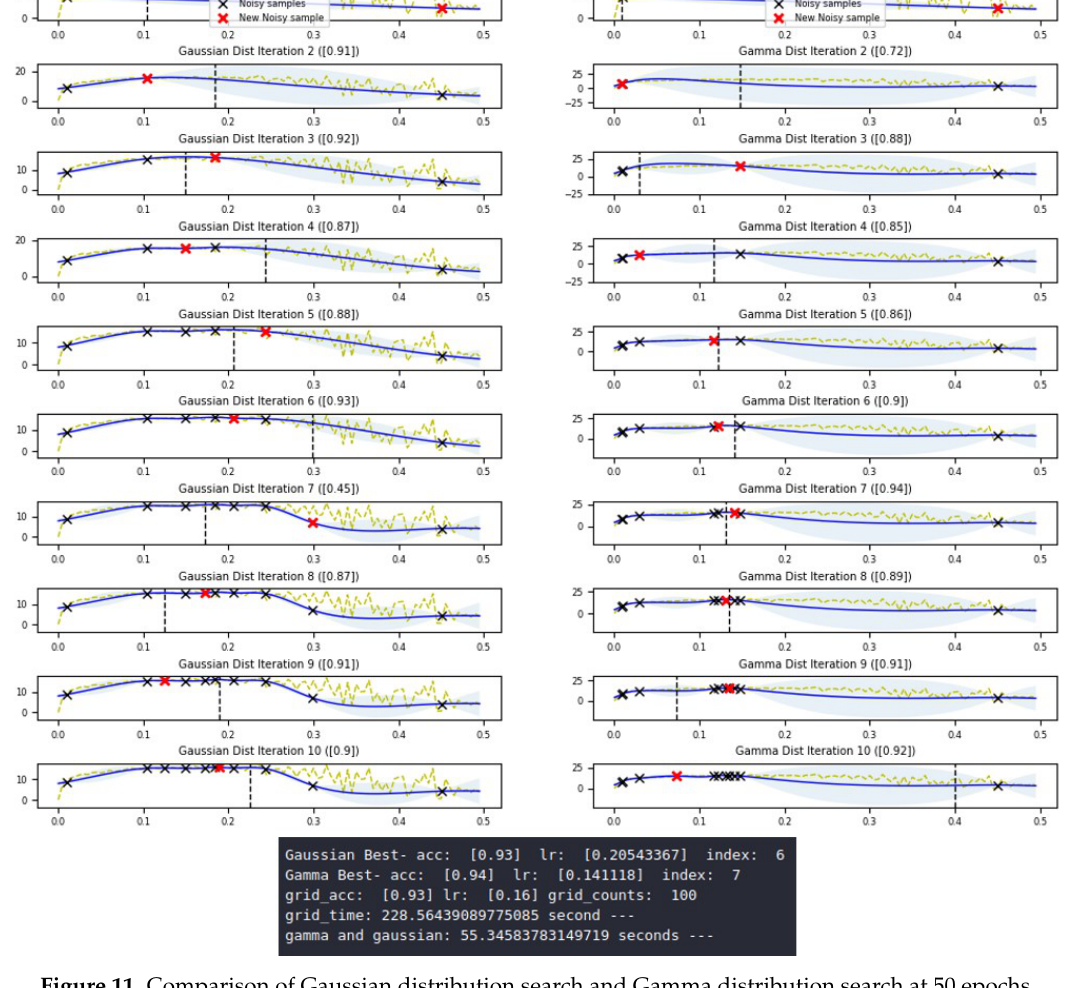
Figure 11. Comparison of Gaussian distribution search and Gamma distribution search at 50